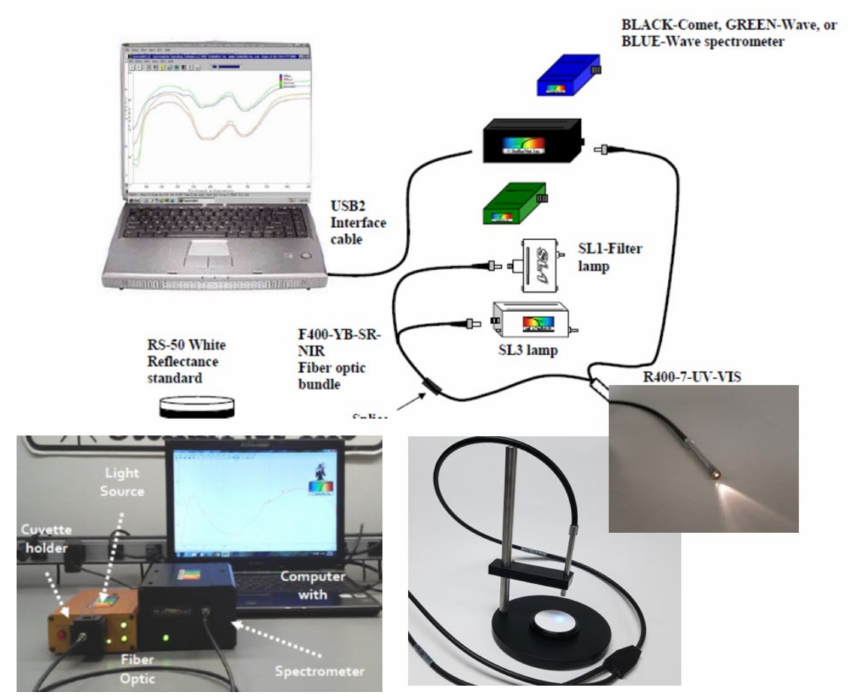
Figure 3. StellarNet BLUE-Wave Spectrometer STN–BW–VIS with the reflectance probe and probe holder for the light spectral reflectance